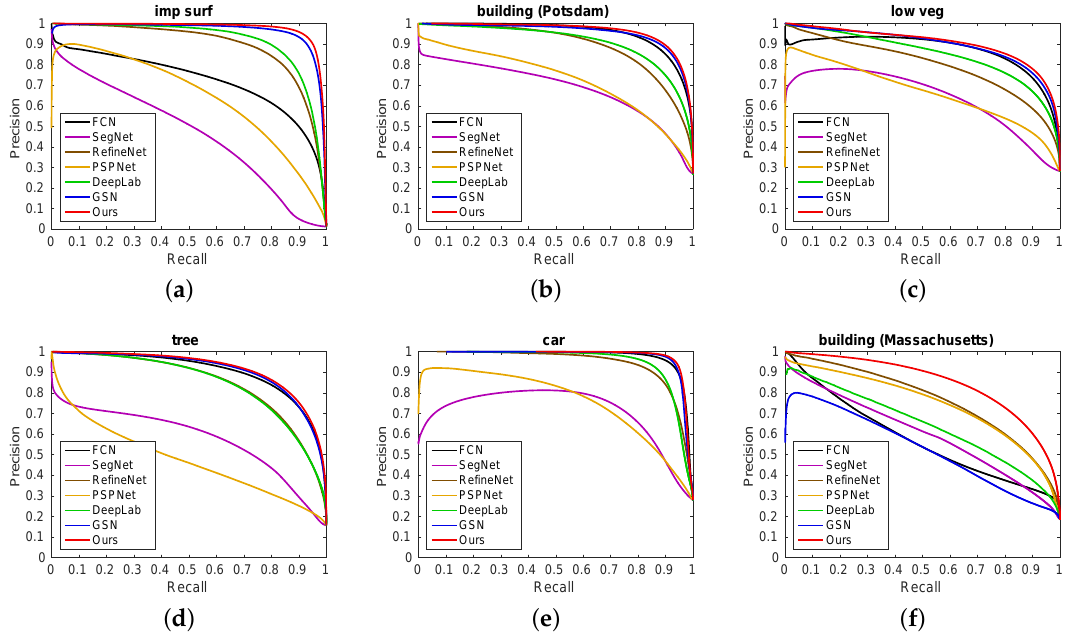
Figure 3. Precision-recall (PR) curves obtained by all seven compared models. First five subfigures were calculated on the Potsdam dataset and the last subfigure was calculated on the Massachusetts building dataset. ( a ): imp surf; ( b ): building (Potsdam); ( c ): low veg; ( d ): tree; ( e ): car; and ( f ): building